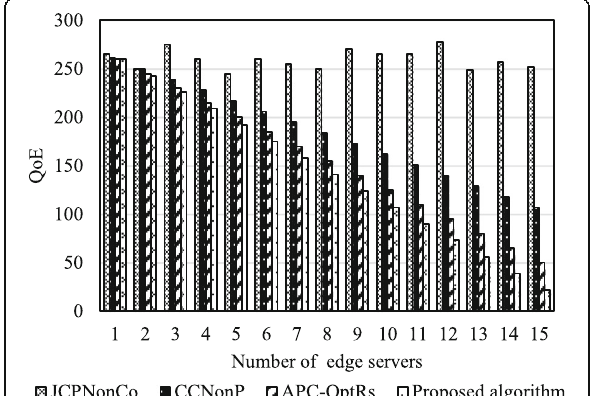
Fig. 9 QoE function changes with the number of edge